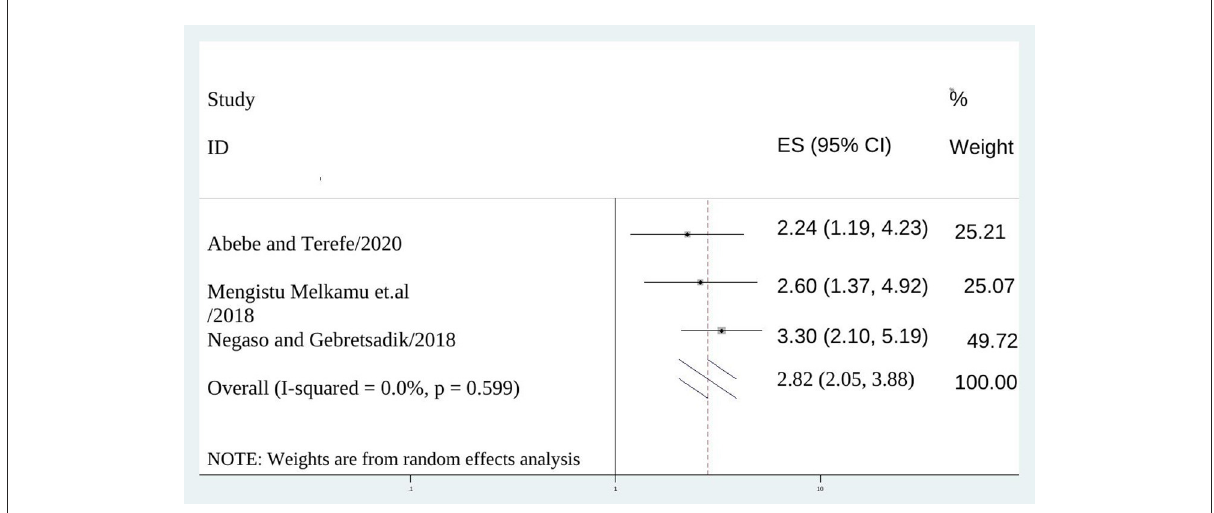
FIGURE6 The association between not scheduled for follow up and discontinuation of long acting reversible contraception.